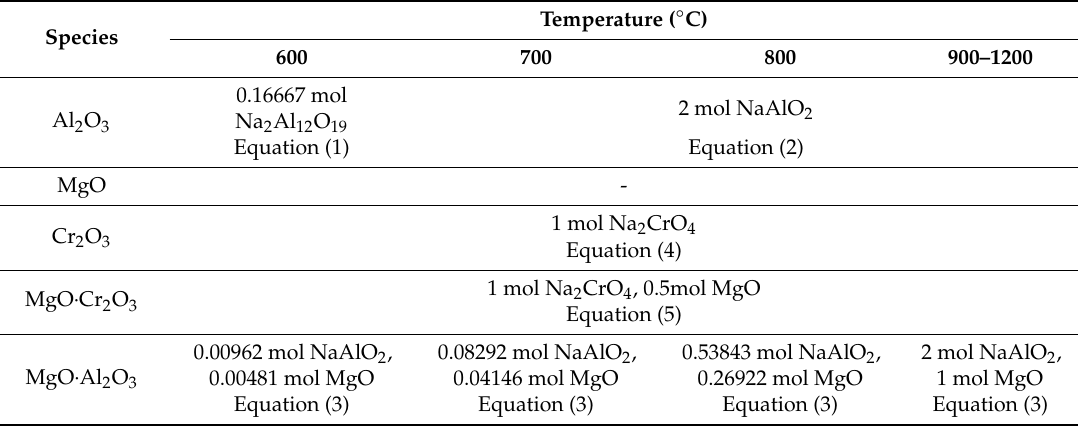
Table 1. Predicted corrosion products and reaction equations of Na 2 CO 3 on refractory materials at 600–1200 ◦ C. Temperature ( ◦ C) Species 600 700 800 900–1200 0.16667 mol 2 mol NaAlO 2 Al 2 O 3 Na 2 Al 12 O 19 Equation (1) Equation (2) MgO - 1 mol Na 2 CrO 4 Cr 2 O 3 Equation (4) 1 mol Na 2 CrO 4 , 0.5mol MgO MgO · Cr 2 O 3 Equation (5) 0.00962 mol NaAlO 2 , 0.08292 mol NaAlO 2 , 0.53843 mol NaAlO 2 , 2 mol NaAlO 2 , MgO · Al 2 O 3 0.00481 mol MgO 0.04146 mol MgO 0.26922 mol MgO 1 mol MgO Equation (3) Equation (3) Equation (3) Equation